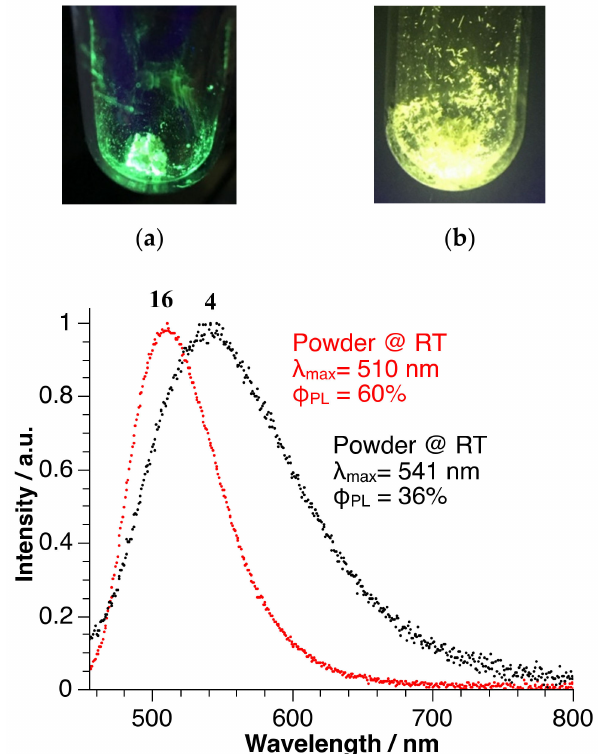
Figure 3. Normalized room-temperature emission spectra for [(CuPPh 3 ) 2 (CDP(Py) 2 )](PF 6 ) 2 ( 4 ) and [(CuSPh) 2 (CDP(CH 2 PPh 2 ) 2 ] ( 16 ). ( a ) illustrates the photoluminescence upon irradiation with UV light at room temperature of 16 , ( b ) of complex 4